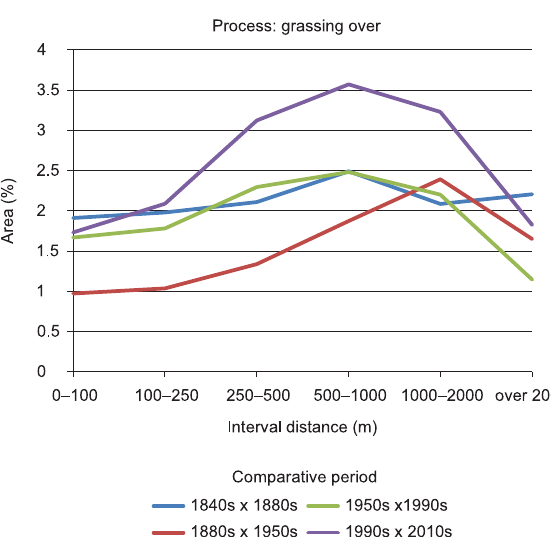
Fig. 12. Grassing in the Hodonín region at various distances from existing